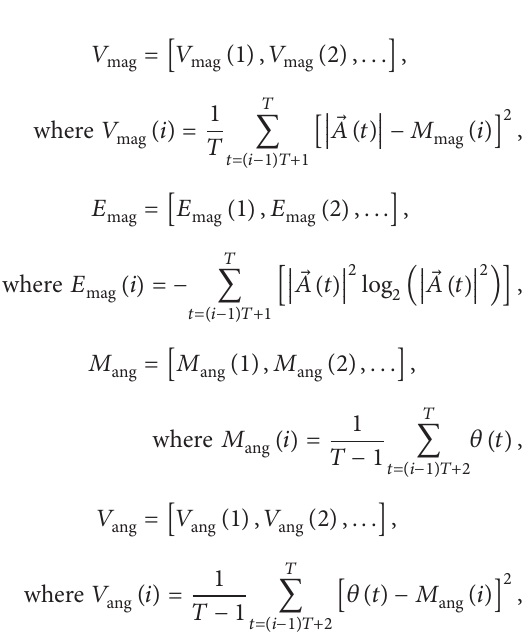
To explore the performance and correlation among these six features, a series of scatter plots in a 2D feature space is shown in Figure 2. The horizontal and vertical axes represent two different features. The points in different colors represent different activities. In Figure 2(a), the relationship between 𝑀 and 𝑉 is described, and the running, jumping, mag mag walking, and static activities are clustered. In Figure 2(b), the straight line between 2D walking (forward, left, and right) and 3D walking (upstairs and downstairs) implies that 𝑀 is an available feature. Figure 2(c) illustrates that the ang 𝐸 and 𝑀 features successfully partition the triaxial mag mag acceleration data samples from walking forward, walking